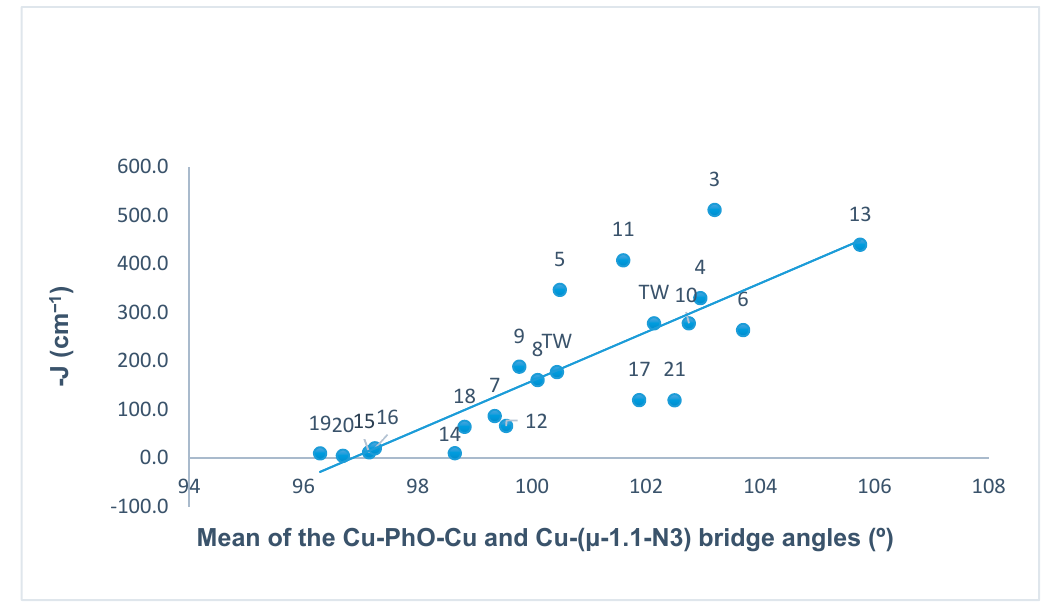
Figure 17. Plot of the antiferromagnetic interaction (–J) vs. the averaged Cu–OPh–Cu and Cu–( μ -N 3 ) angle in dinuclear ( μ -phenolate/ μ -azido bridged) copper(II) complexes.